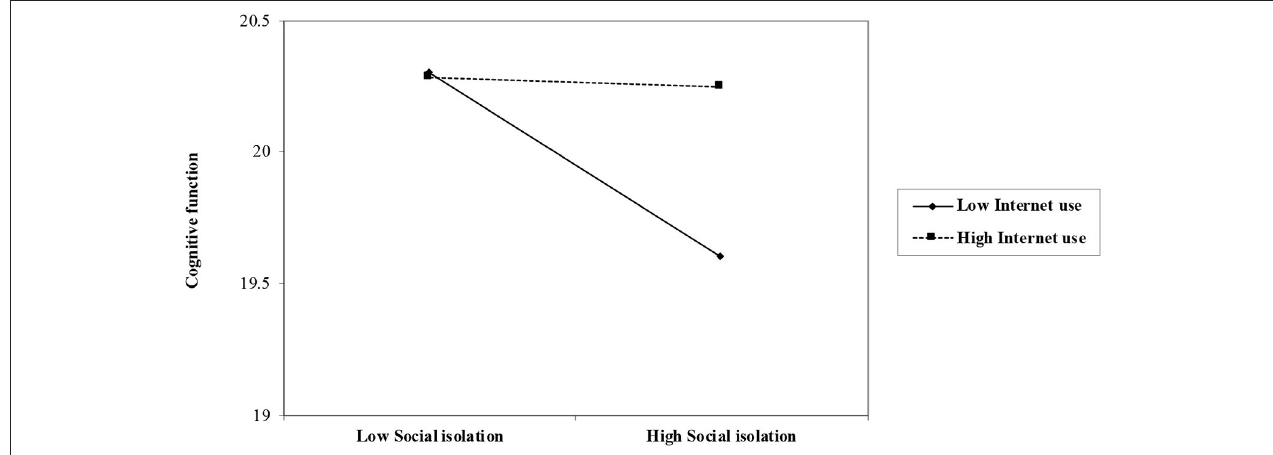
FIGURE 2 | Role of social isolation on cognitive function by levels of internet use among the entire sample ( N = 8,835).